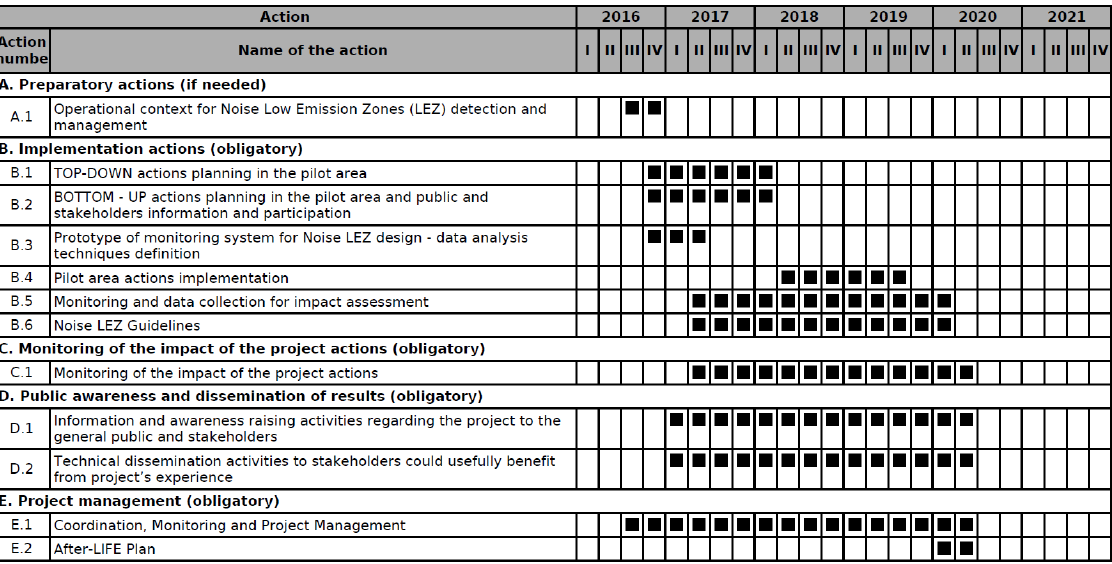
Figure 3: LIFE MONZA timetable.